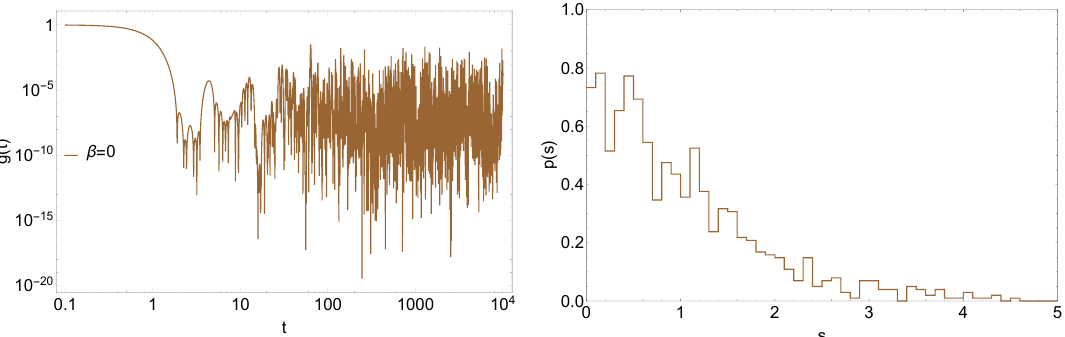
Figure 18. SFF and level spacing plot for SYK2 model with number of sites N = 24 , J = 1 and without disorder